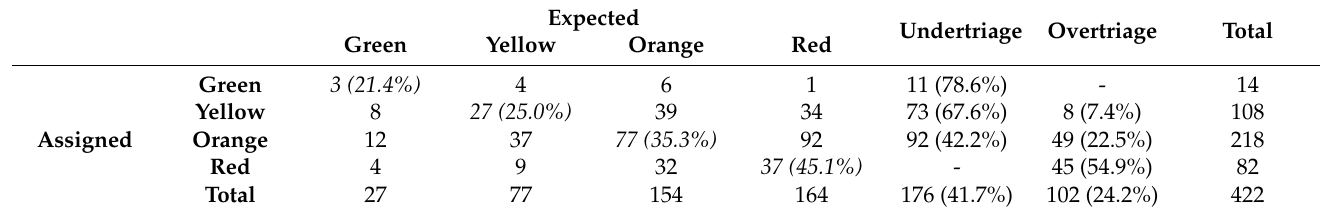
Table A3. Comparison of the triage code originally assigned by local personnel and the code retrospectively obtained by researchers for paediatric cases. The results in italics represent the number of correct triages performed by local personnel; those above and below them identify the percentage of over- and undertriage per category,